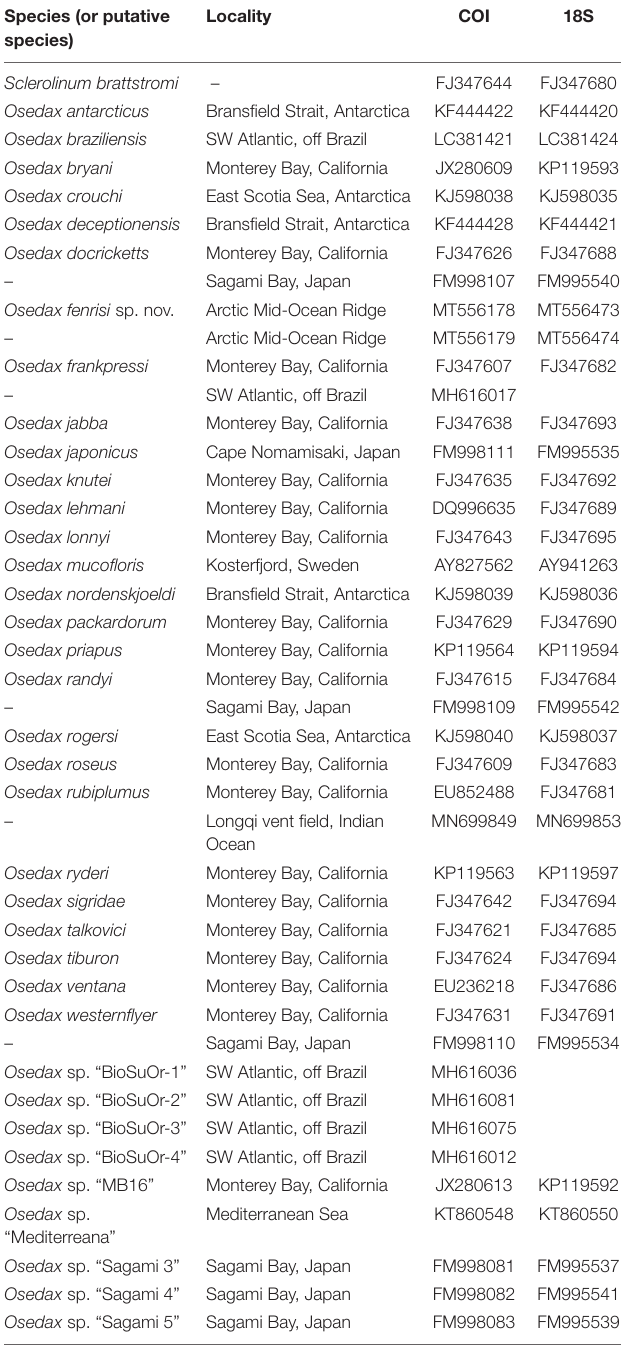
TABLE 2 | Specimens included in the phylogenetic analyses with GenBank